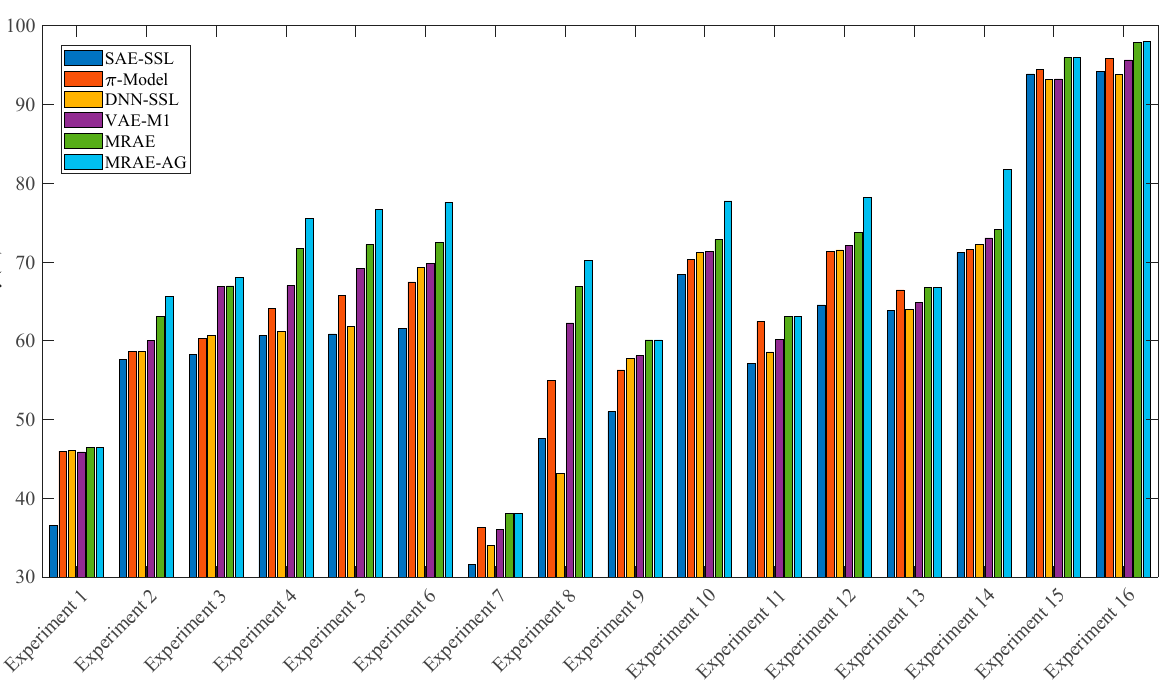
Figure 9. Histogram of all experiment